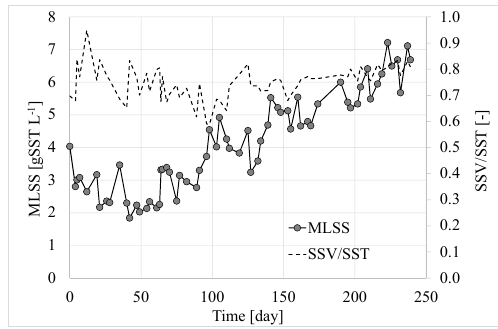
Figure 2. Suspended biomass trend and volatile suspended solid/total suspended solid (VSS/TSS) ratio during the experiments.